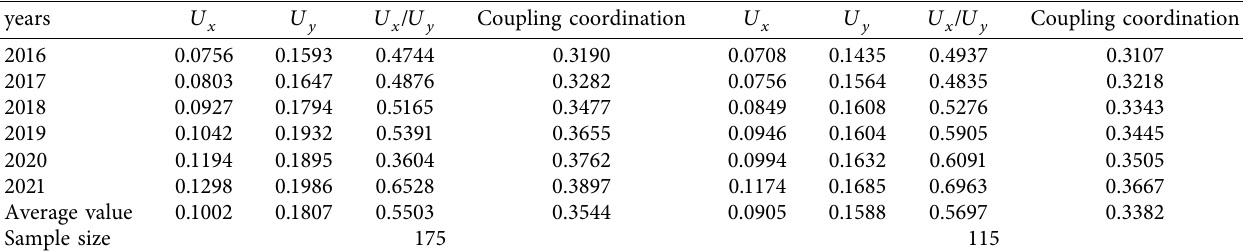
Table 7: Coupling and coordination characteristics of digital economy and high-quality development in the Yangtze and Yellow River basins.